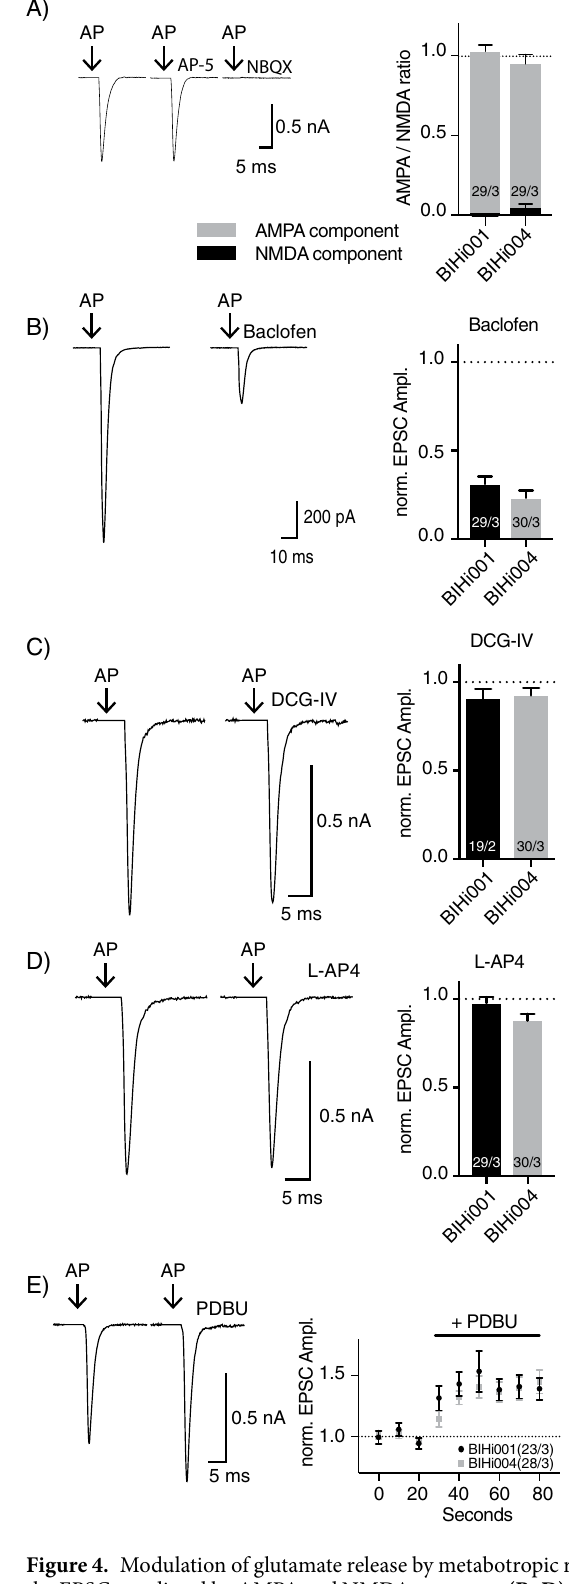
Figure 4. Modulation of glutamate release by metabotropic receptors and phorbol esters. ( A) Components of the EPSCs mediated by AMPA and NMDA receptors. (B–D) Comparison of EPSC amplitudes with and without Baclofen ( B ), L-AP4 ( C ) and DCG-IV ( D ). ( E) EPSC potentiation by application of PDBu. AP artefacts were blanked and are indicated by black arrows. The numbers of neurons and independent cultures analysed are shown within the bars. Data are expressed as mean ±